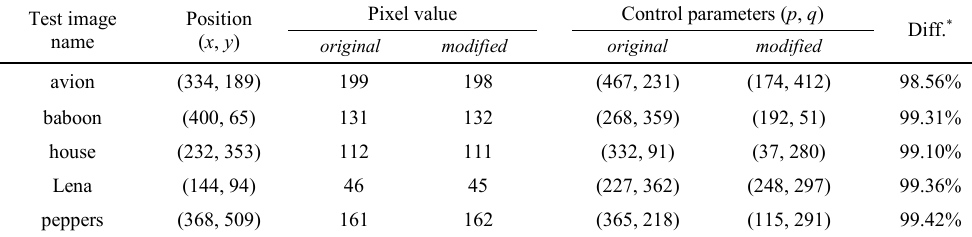
Table 1. Differences between shuffled images produced from original images with only 1-bit difference